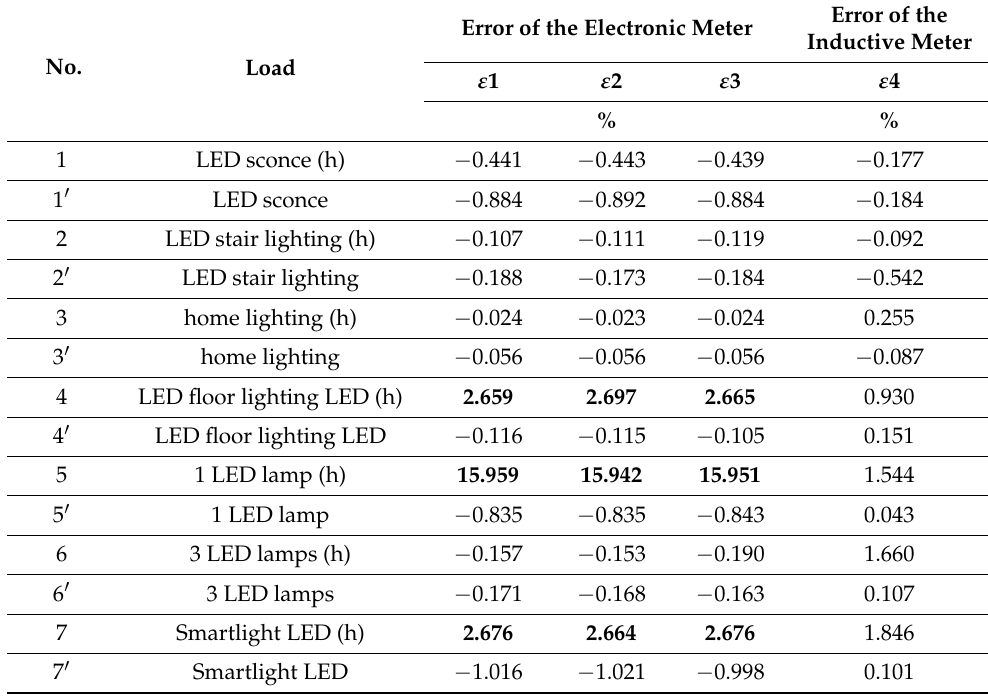
Error of Error of the Electronic Meter